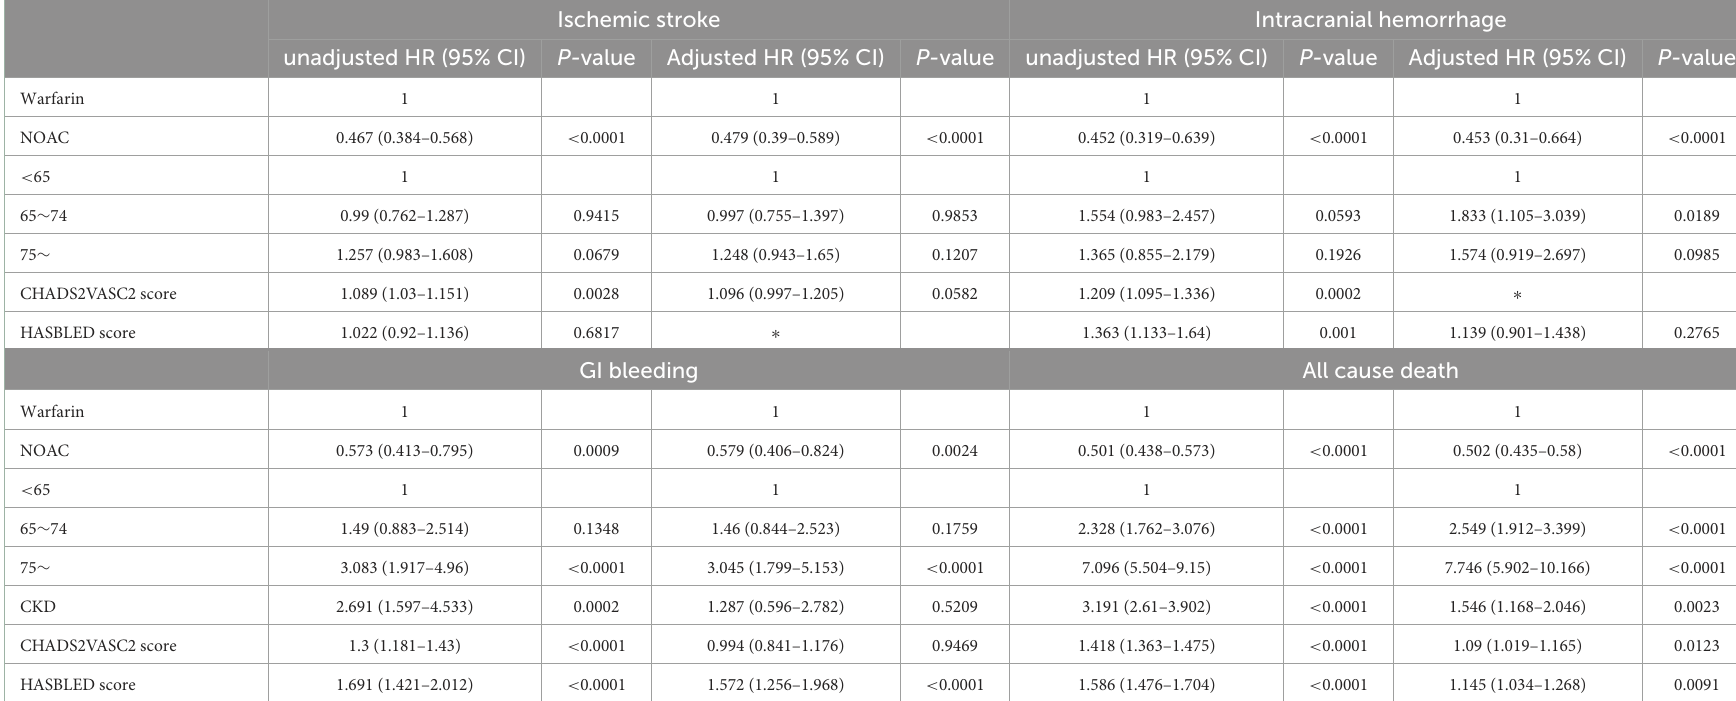
TABLE 2 Hazards for ischemic stroke, intracranial hemorrhage, GI bleeding and all cause death (CDW + C